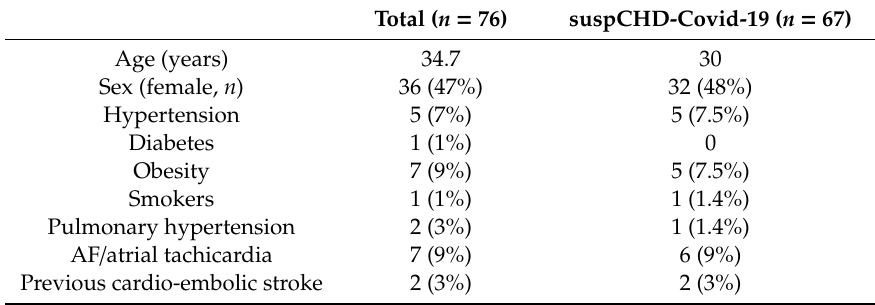
Table 1. Clinical characteristics of patients with Congenital Heart Disease and COVID-19 infection.